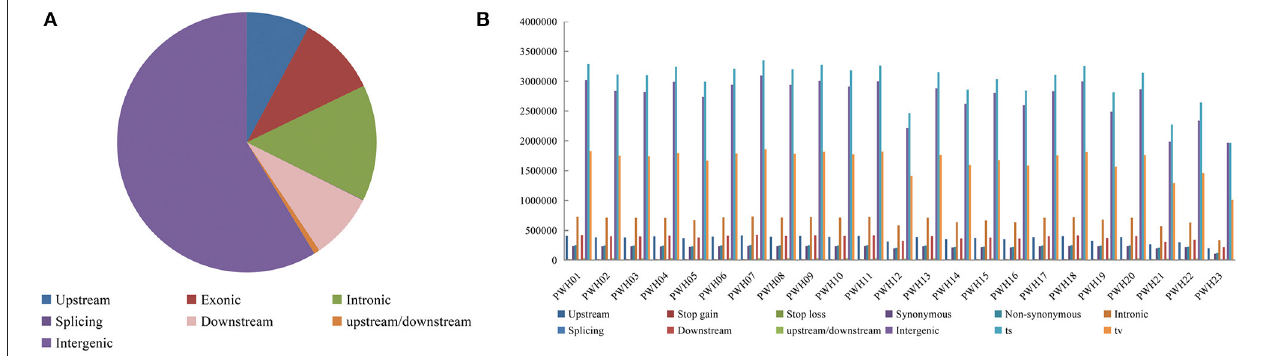
Regarding InDels, the number of InDels mutations detected ranged from 340,234 ( P . communis L. cv. Early Red Comic) to 694,630 (PWH01). And the total number of InDel variants amounted to 14,186,626, of which 6,355,526 were insertions and 7,831,100 deletions showing that the numbers of